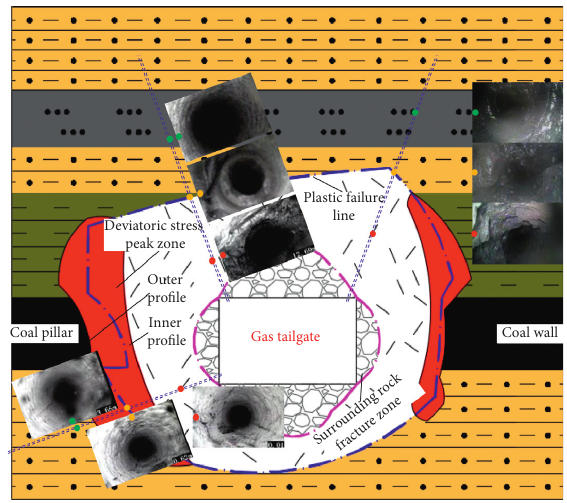
Figure 11: Contrast diagram of relationship between peak devi- ating stress band and plastic